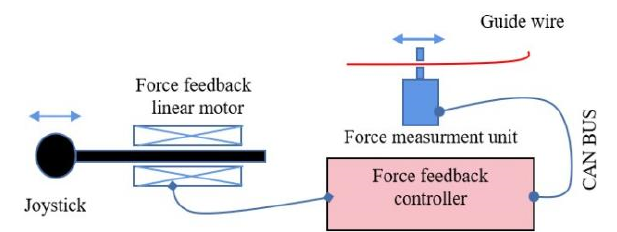
Figure 7. The illustration of force feedback handle.